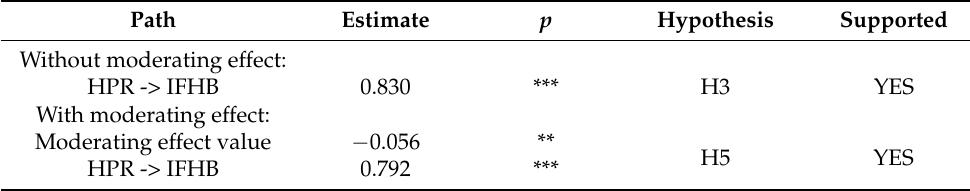
Figure 8. Estimation results of the moderating effect of FSIR. Table 9. Detailed results of the moderating effect of FSIR.